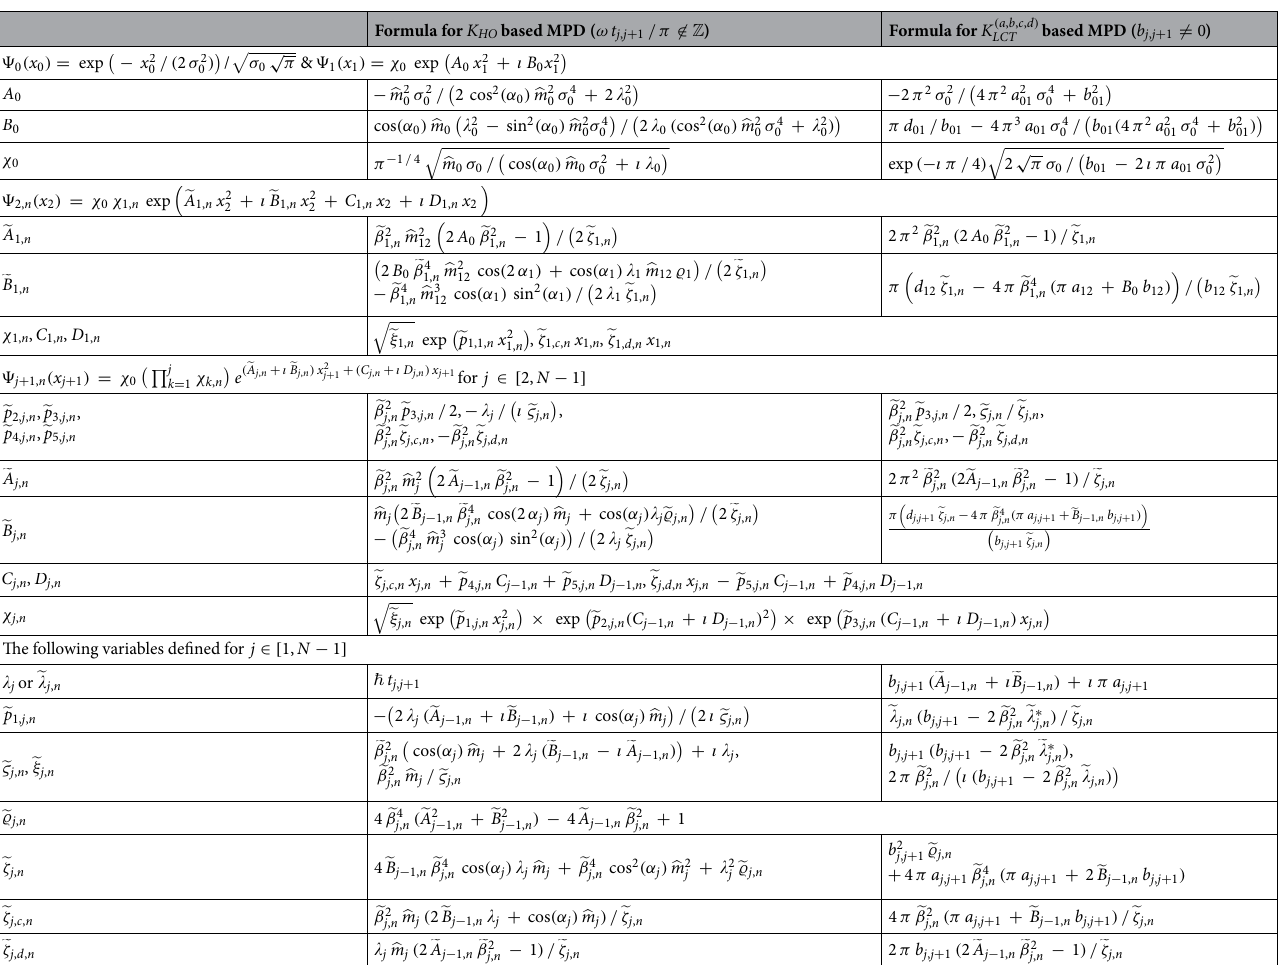
( a , b , c , d ) LCT for Gaussian